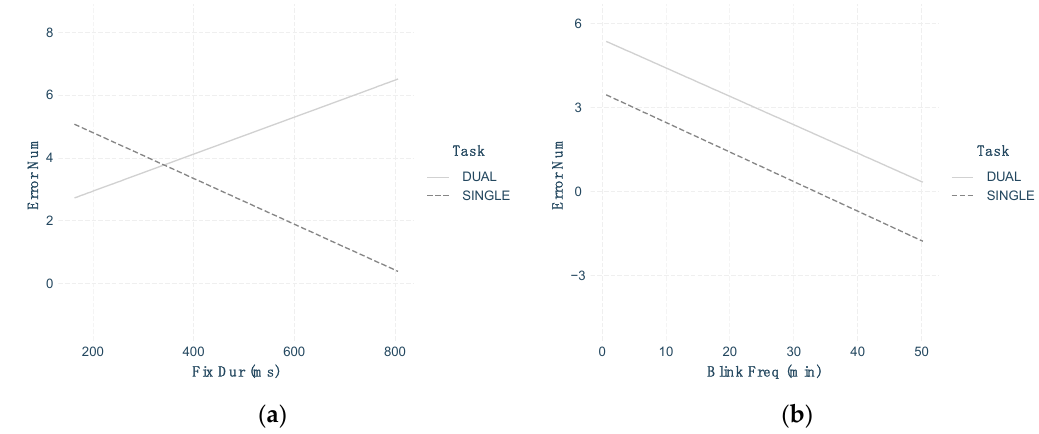
Figure 13. Interactions of the regression model: fixation duration × task ( a ) and blink frequency × task ( b ).